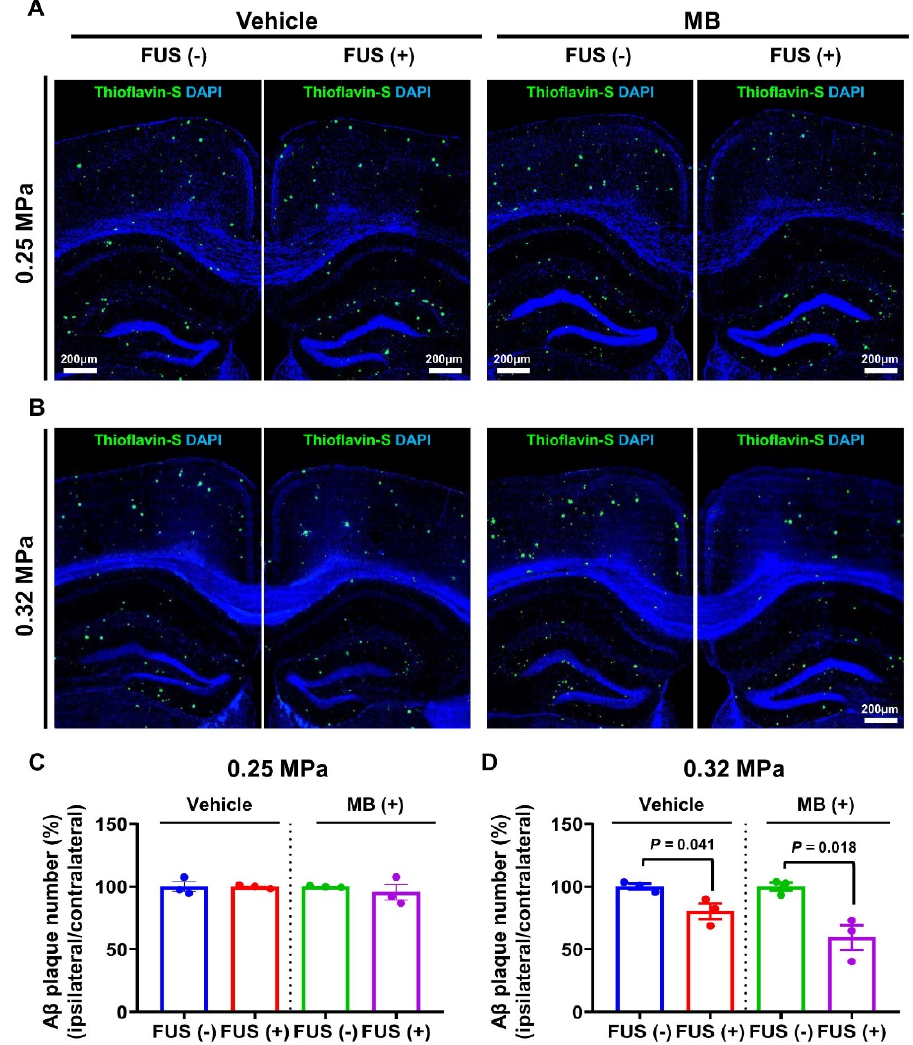
Figure 4. A β plaque deposition in FUS-treated and FUS/MB-treated APP/PS1 mice. ( A , B ) Thioflavin-S staining in the cortex and hippocampal regions revealed representative A β plaque deposition (green fluorescence) in the 0.25 MPa ( A ) and 0.32 MPa ( B ) groups. ( C , D ) The number of A β plaques in the cortex and hippocampal regions of animals in the 0.25 MPa ( C ) and 0.32 MPa ( D ) groups was determined. Data are presented as mean ± SEM (number of animals, N = 3; number of slices of each specimen, n = 3). Statistical significance was analyzed using a two-tailed unpaired t -test. Scale bars represent 200 µ m in ( A , B